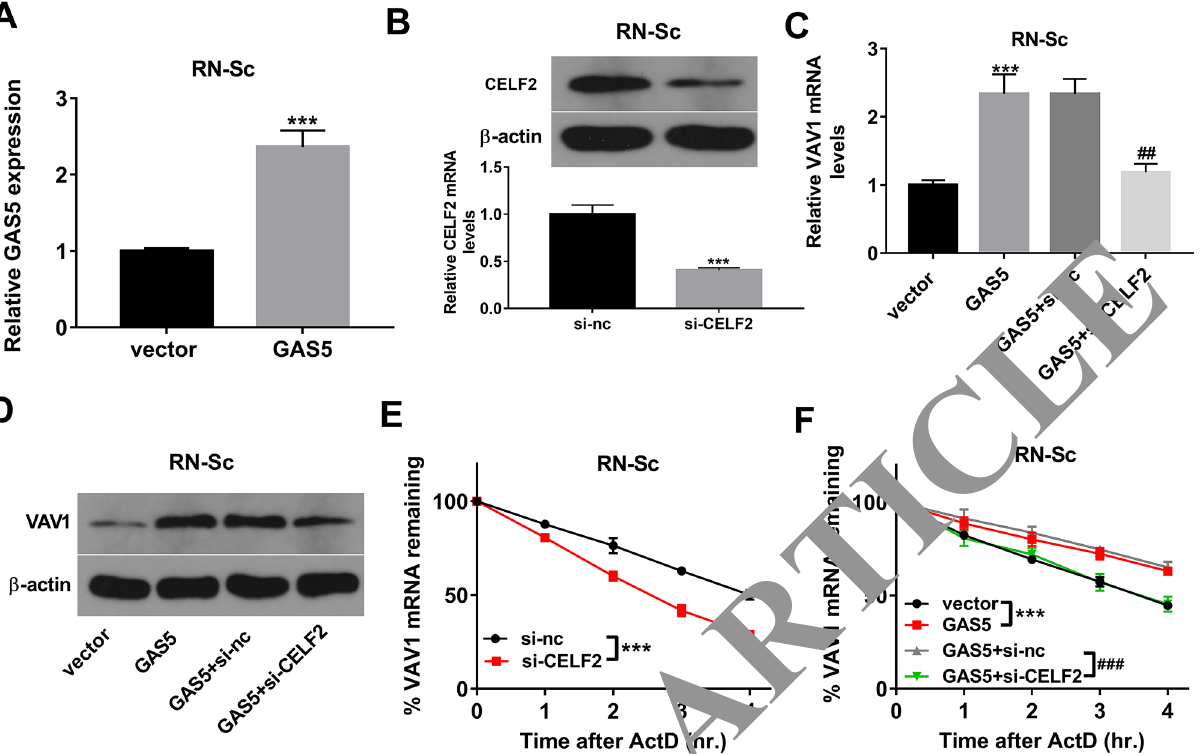
Figure 4. GAS5 facilitated VAV1 mRNA and protein expression and increased VAV1 mRNA stability via recruiting CELF2. ( A ) RN-Sc cells were transfected with empty vector or GAS5 overexpression plasmid, followed by the measurement of GAS5 level at 48 h post transfection. ( B ) RN-Sc cells were transfected with si-nc or si-CELF2. Forty-eight hours later, CELF2 mRNA and protein levels were detected by RT-qPCR and western blot assays, respectively. ( C , D ) RN-Sc cells were transfected with empty vector, GAS5 overexpression plasmid, GAS5 overexpression plasmid + si-nc, or GAS5 overexpression plasmid + si-CELF2, followed by the examination of VAV1 mRNA and protein levels at 48 h after transfection. ( E ) RN-Sc cells were transfected with si-nc or si-CELF2. At 24 h after transfection, actinomycin D assay was performed to investigate the effect of CELF2 loss on VAV1 mRNA stability. ( F ) RN-Sc cells were transfected with empty vector, GAS5 overexpression plasmid, GAS5 overexpression plasmid + si-nc, or GAS5 overexpression plasmid + si-CELF2, followed by the detection of VAV1 mRNA stability via actinomycin D assay at 24 h post transfection. ** P < 0.01, *** P < 0.001, ## P <